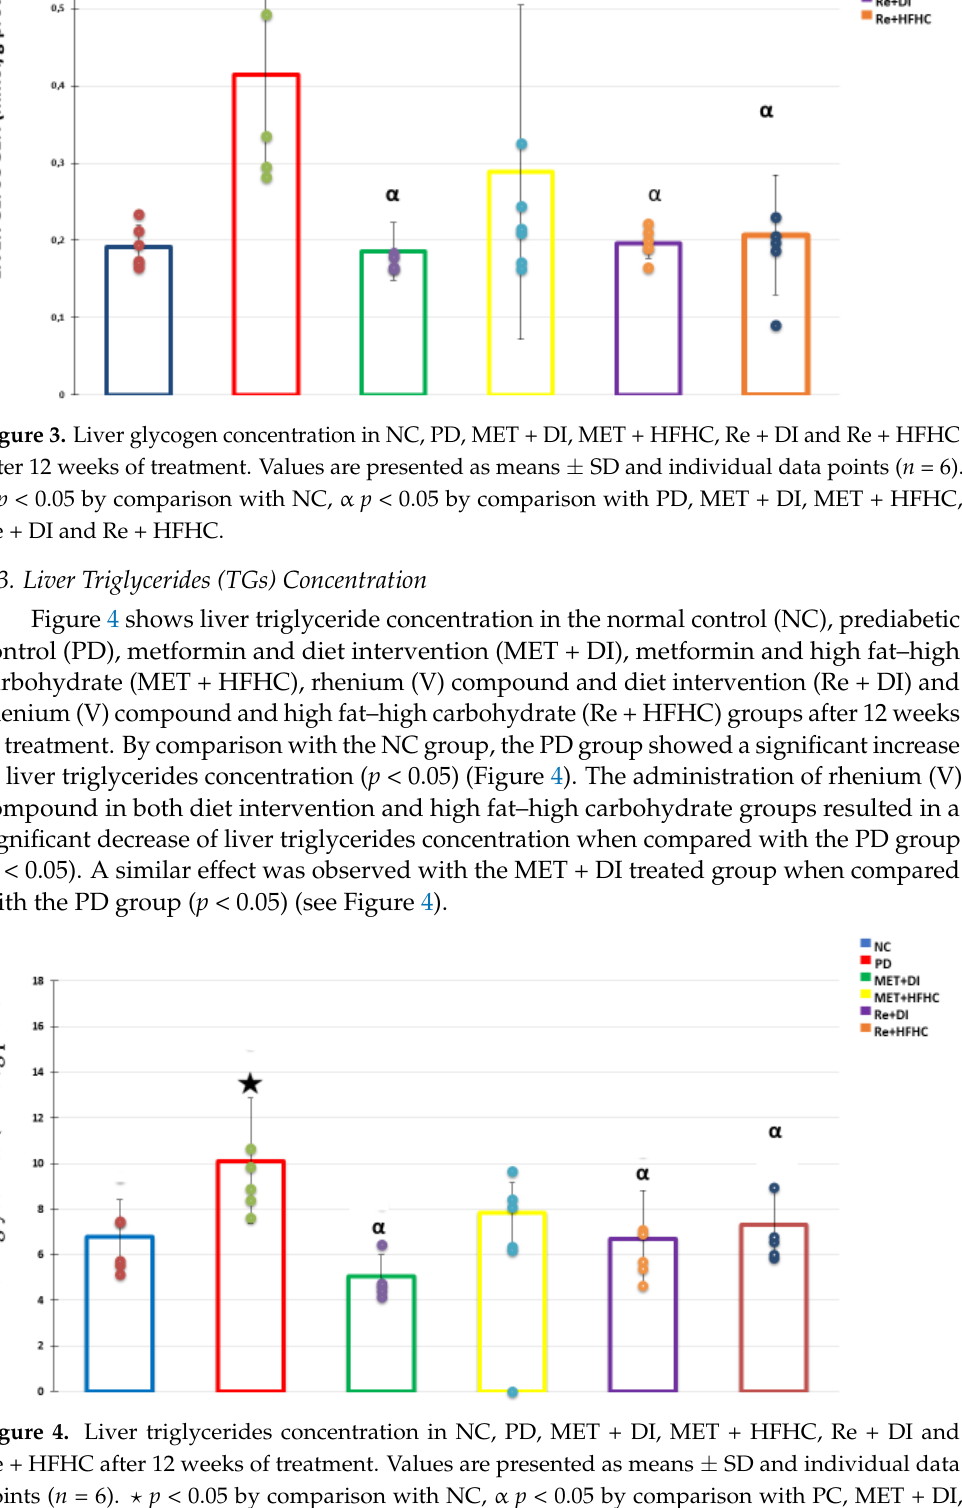
Figure 2. Fasting blood glucose in NC, PD, MET + DI, MET + HFHC, Re + DI and Re + HFHC at 12 weeks of treatment. Values are presented as means ± SD ( n = 6). * p < 0.05 by comparison with NC, α p < 0.05 by comparison with PD, MET + DI, MET + HFHC, Re + DI and Re + HFHC. 3.2. Liver Glycogen Concentration Figure 3 shows liver glycogen levels in the normal control (NC), prediabetic control (PD), metformin and diet intervention (MET + DI), metformin and high fat–high carbohy- drate (MET + HFHC), rhenium (V) compound and diet intervention (Re + DI) and rhenium (V) compound and high fat–high carbohydrate (Re + HFHC) groups after 12 weeks of